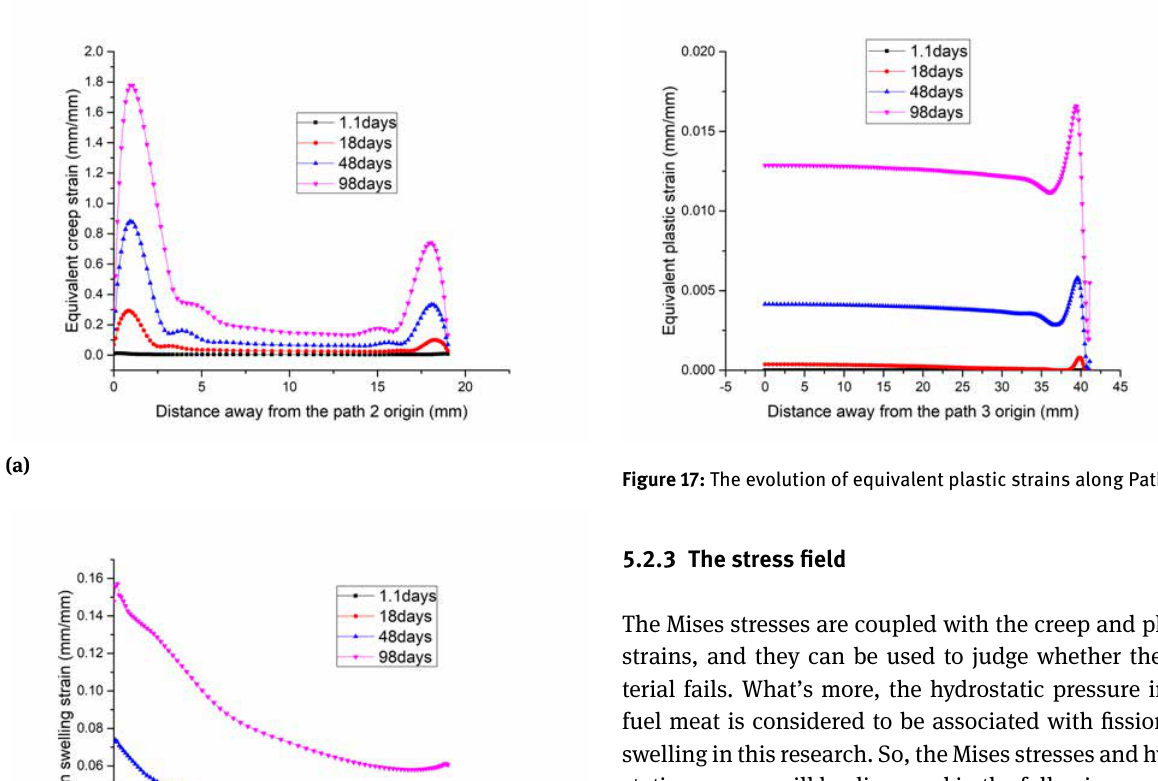
It is shown that equivalent plastic strains increase with irradiation time; the maximum magnitudes appear near the path end; the distribution and evolution patterns stem from irradiation swelling and creep effects occurring in the fuel meat, as explained above.